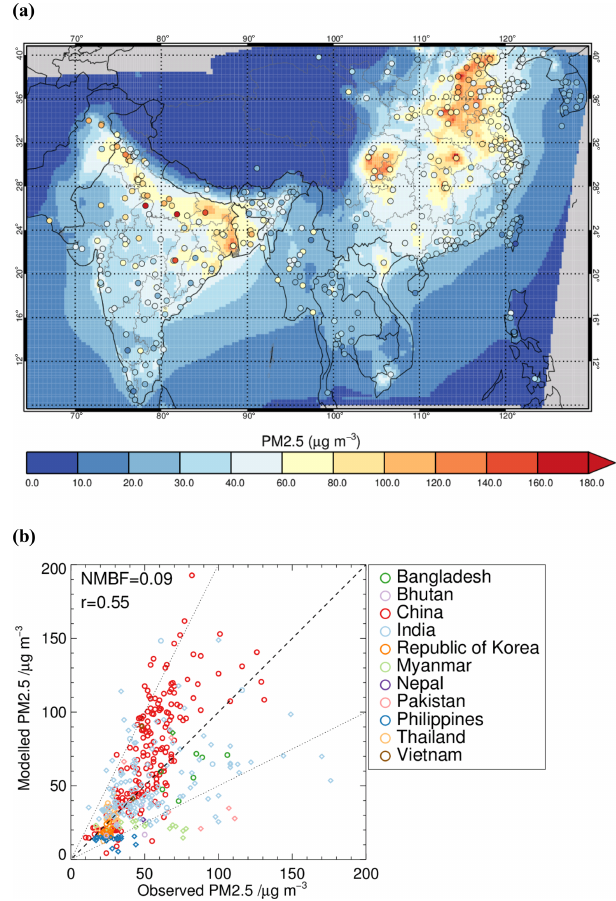
Figure 1. Simulated and measured annual mean surface PM 2 . 5 con- centrations across South and East Asia. Observation data are from the World Health Organization database, 2016 and 2018. (a) Map of the simulated surface distribution of annual mean PM 2 . 5 for 2014 (underlying colours); overlying circles show measured annual mean PM 2 . 5 concentrations for available years (2009–2016). Regions in grey are outside the model domain. (b) Simulated versus measured annual mean PM 2 . 5 concentrations. Circles show measured annual mean PM 2 . 5 concentrations for the year 2014; diamonds show mea- sured annual mean PM 2 . 5 concentrations for years other than 2014. All simulated annual mean PM 2 . 5 concentrations are for the year 2014. The normalized mean bias factor (NMBF; Yu et al., 2006) and Pearson’s correlation coefficient ( r ) between simulated and mea- sured values are displayed in the top left